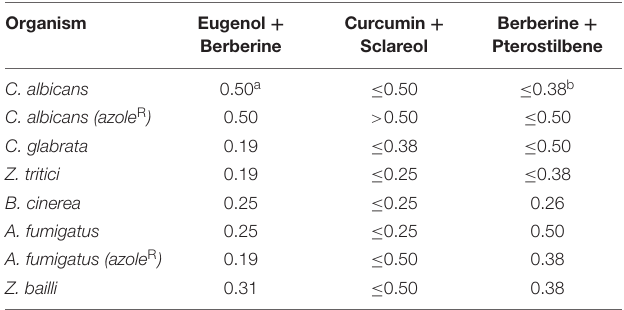
TABLE 1 | Values for FIC index for selected NP combinations against diverse human-, plant-pathogenic, and spoilage fungi.